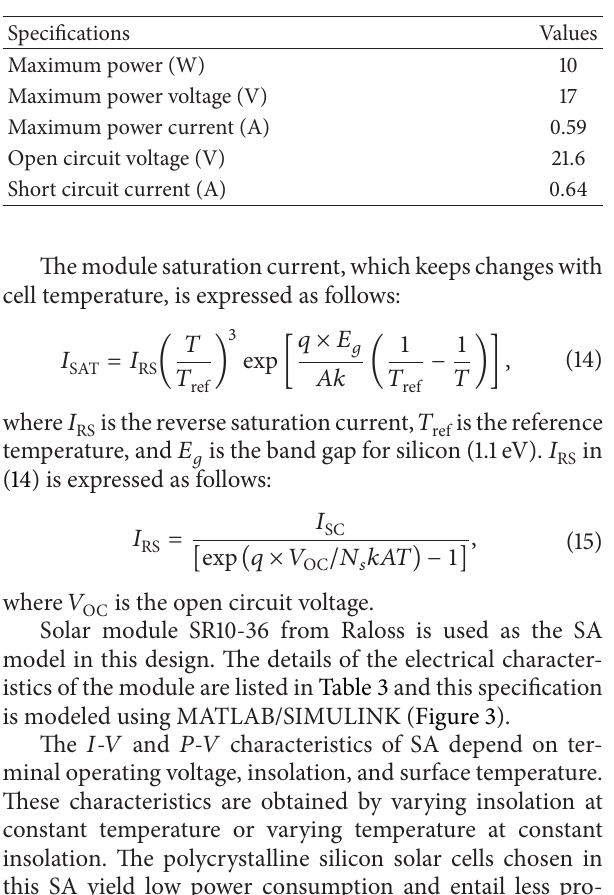
Table 3: Specification of solar module